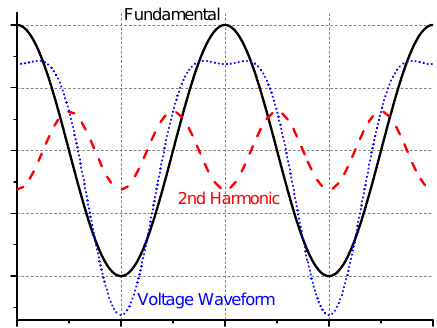
Figure 5. Theoretical gate waveform for class-C-F PA.